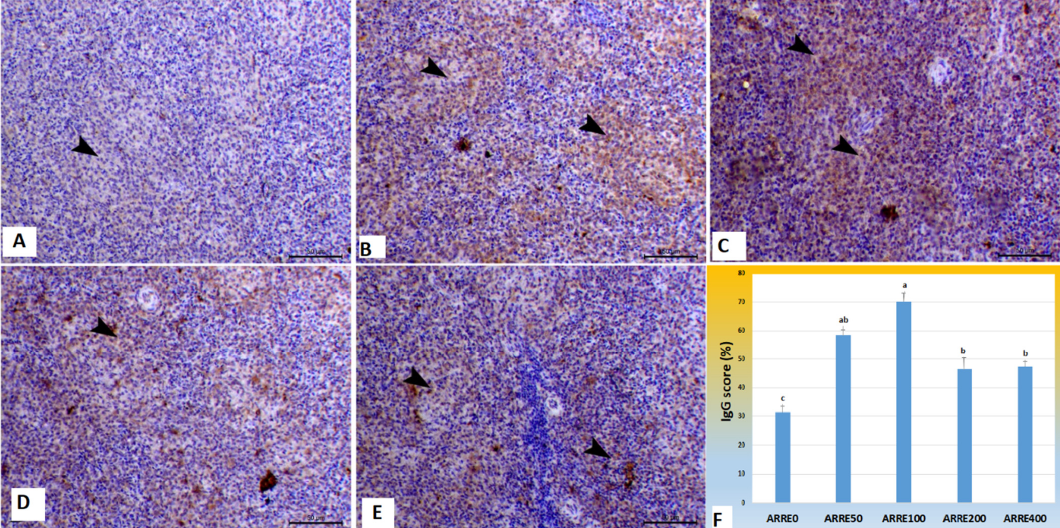
Figure 3. Photomicrograph of splenic tissues immunostained with IgG antibody: ( A ) spleen of ARRE0 group showing mild expression of IgG (31.42%) within white pulp (arrowhead); ( B ) The spleen of the ARRE50 group showed an increase of IgG immunostaining expression of IgG (58.49%) within white pulp (arrowheads); ( C ) The spleen of ARRE100 showed a marked increase of IgG immunostaining (70.25%) within the white pulp (arrowheads); ( D ) The spleen of ARRE200 showed an increase of immunostaining expression of IgG (46.40%) within the white pulp (arrowheads); ( E ) The spleen of ARRE400 showed increased IgG immunostaining (47.41%) within white pulp (arrowheads). Bar = 50 µ m. ( F ) showed morphometric measures of IgG immunostaining expression (%). a,b means carrying different superscripts are significantly different at ( p <